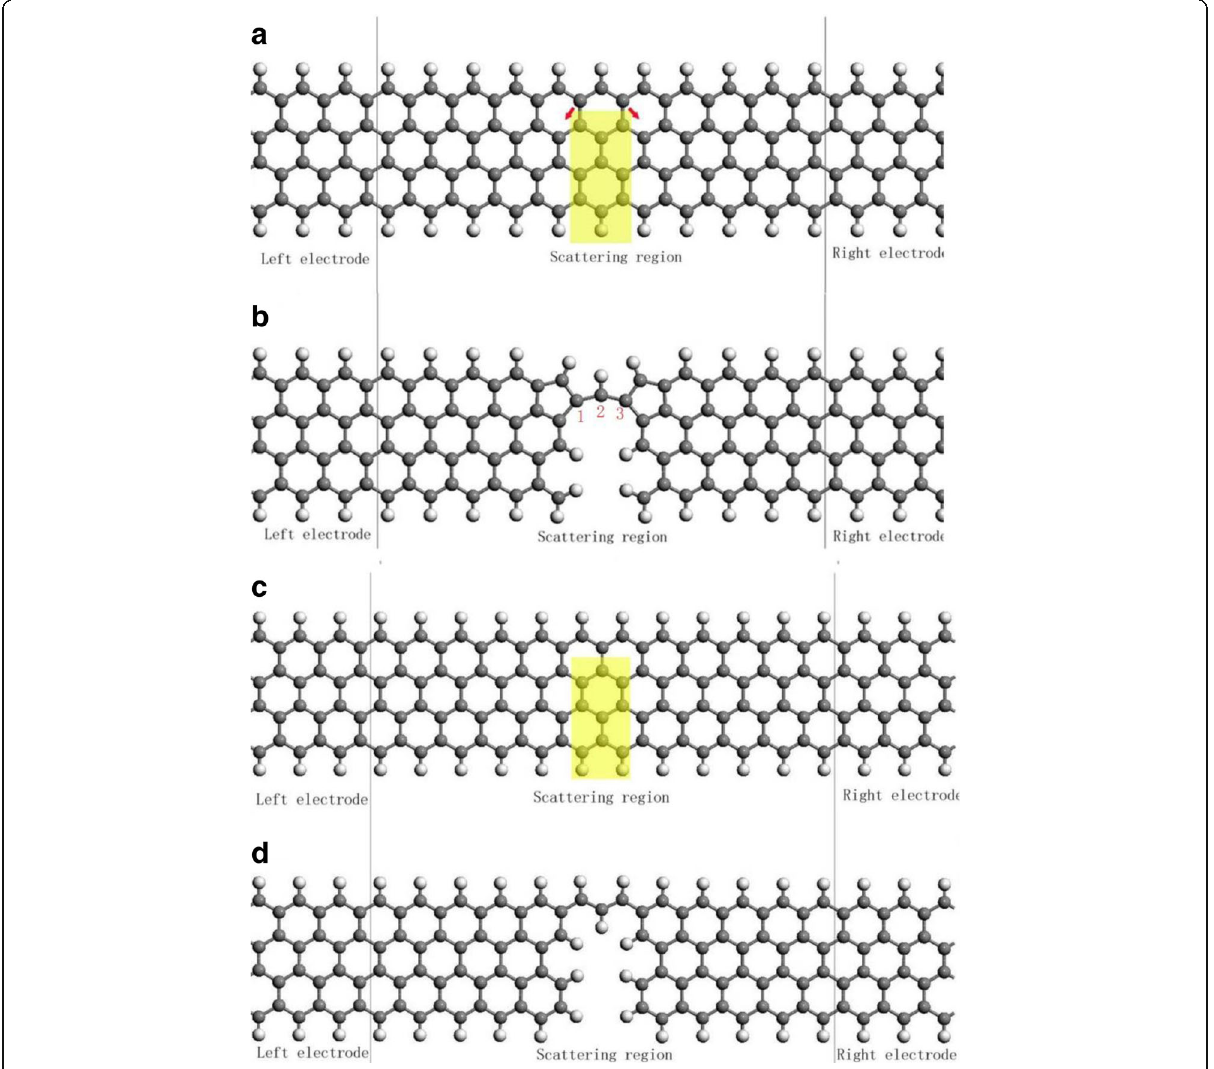
Fig. 1 The schematic zigzag graphene device model by removing the carbon atoms in the yellow rectangular region. b is the relaxed structure with the dangling bonds saturated by hydrogen atoms according to a , d is the relaxed structure with the dangling bonds saturated by hydrogen atoms according to